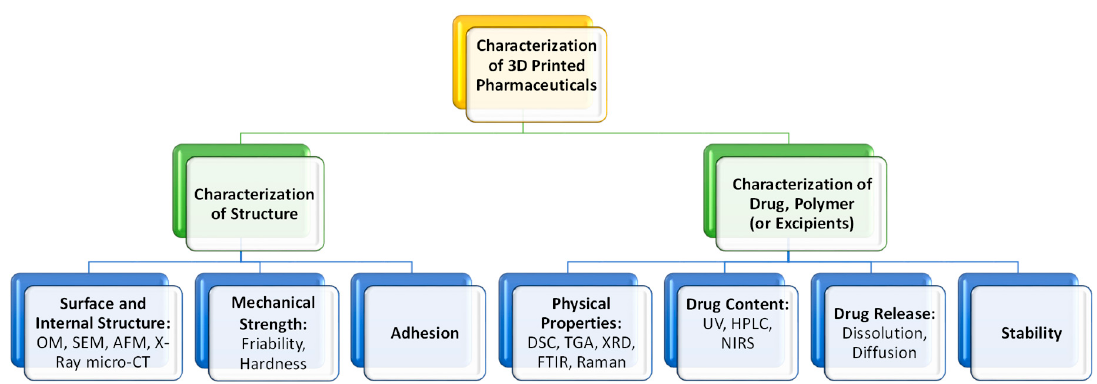
Figure 9. Characterizations required for 3D printed structure, drug, and polymer (or other functional excipients, if necessary).